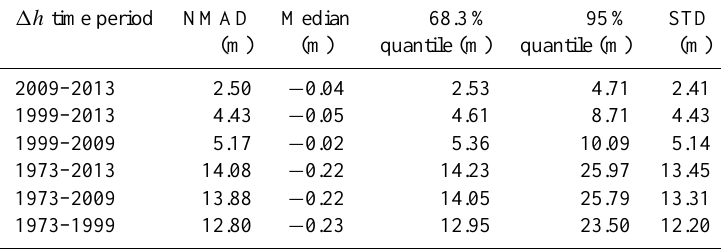
Table 2. Vertical uncertainties of DEM differencing on stable terrain with KH-9 Hexagon (1973), SRTM-3 (1999), ALOS-PRISM (2009), and Pléiades (2013).